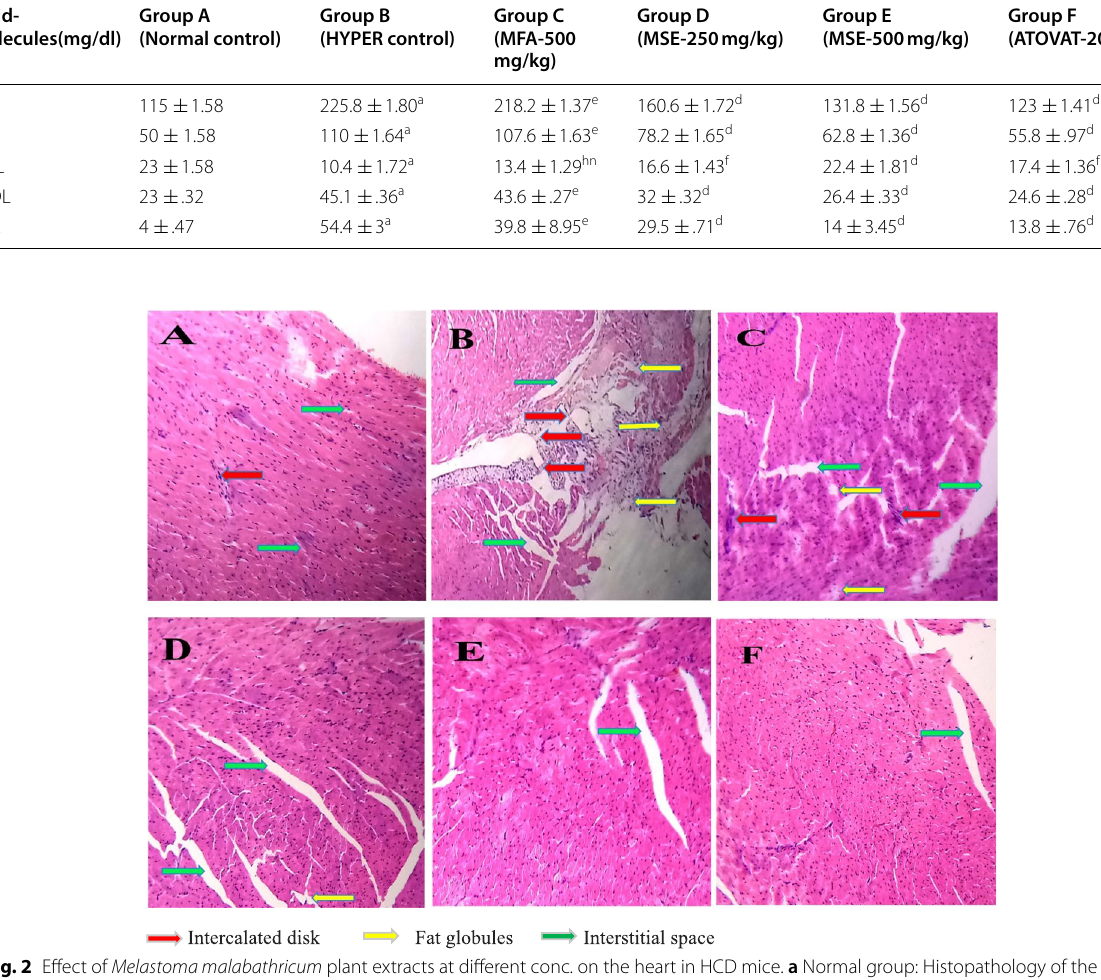
Fig. 2 Effect of Melastoma malabathricum plant extracts at different conc. on the heart in HCD mice. a Normal group: Histopathology of the normal group’s heart demonstrated no changes among the intercalated disk (red arrow) and interstitial space (green arrow). b Hyperlipidemic control: Intercalated disk was contused (red arrow), interstitial space was augmented (green arrow), and cellular deformation was induced due to infiltration of fat molecules (yellow arrow). c MFA-500 mg/kg: Intercalated disk was deteriorated (red arrow), as well as the interstitial space was ameliorated (green arrow) endorsed by amassing fat globules (yellow arrow). d MSE-250 mg/kg: Histopathology of this group’s exhibited enhanced interstitial space without any cellular contortion. A little bit presence of fats was discerned in this analysis (yellow arrow). e MSE-500 mg/kg: This dose showed trivial interstitial space. (Pictures magnification